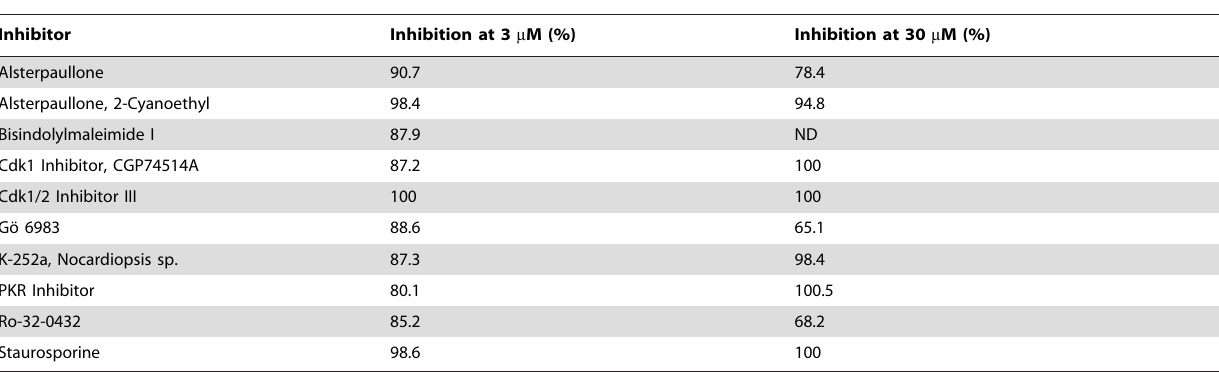
Table 1. Inhibitors of MRCK b in vitro .